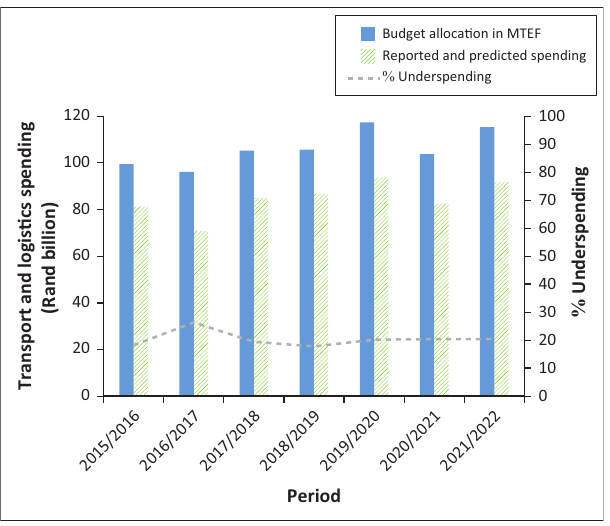
FIGURE 4: Transport infrastructure spending in South Africa (2015/2016 to